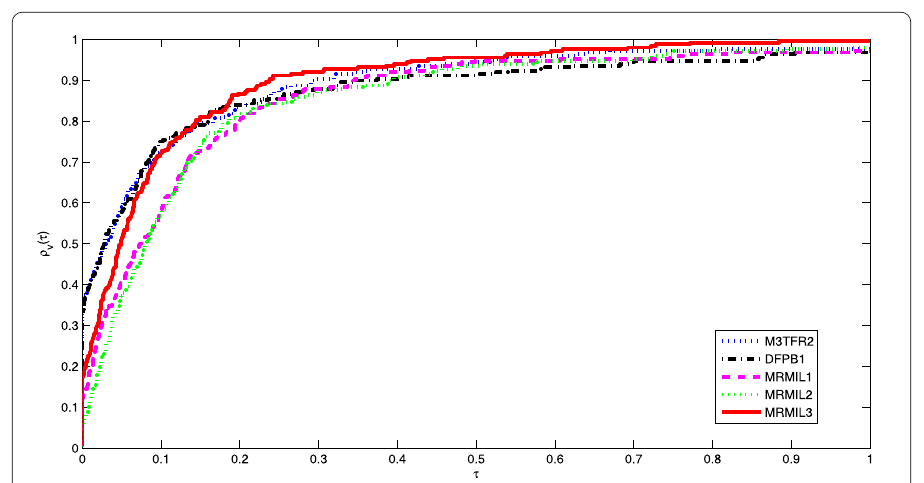
Figure 3 Performance profiles for the CPU time in a log 2